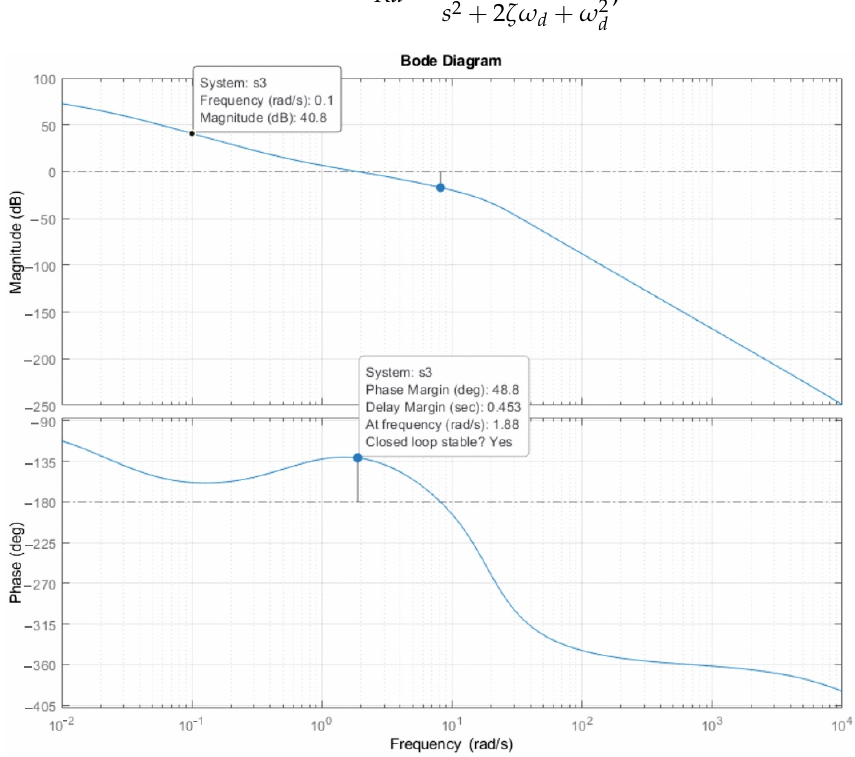
Figure 22. Bode characteristic after using a low-pass filter of the 2nd order. For the correct functionality of the overall designed control system, a simulation of the control circuit (closed loop) for deformation control was performed, providing that if the required value of deformation changed at a constant speed, it would be applied to the input, Figure 23. Figure 23. Block diagram of the control closed-loop circuit. The aim of this simulation was to verify the behavior of the controlled variable on the input signal. In addition, it is also important to determine whether the output variable from the controller is saturated, Figure 24. Based on the computer simulation performed, it can be concluded that the designed controller meets the requirements imposed on the control circuit.